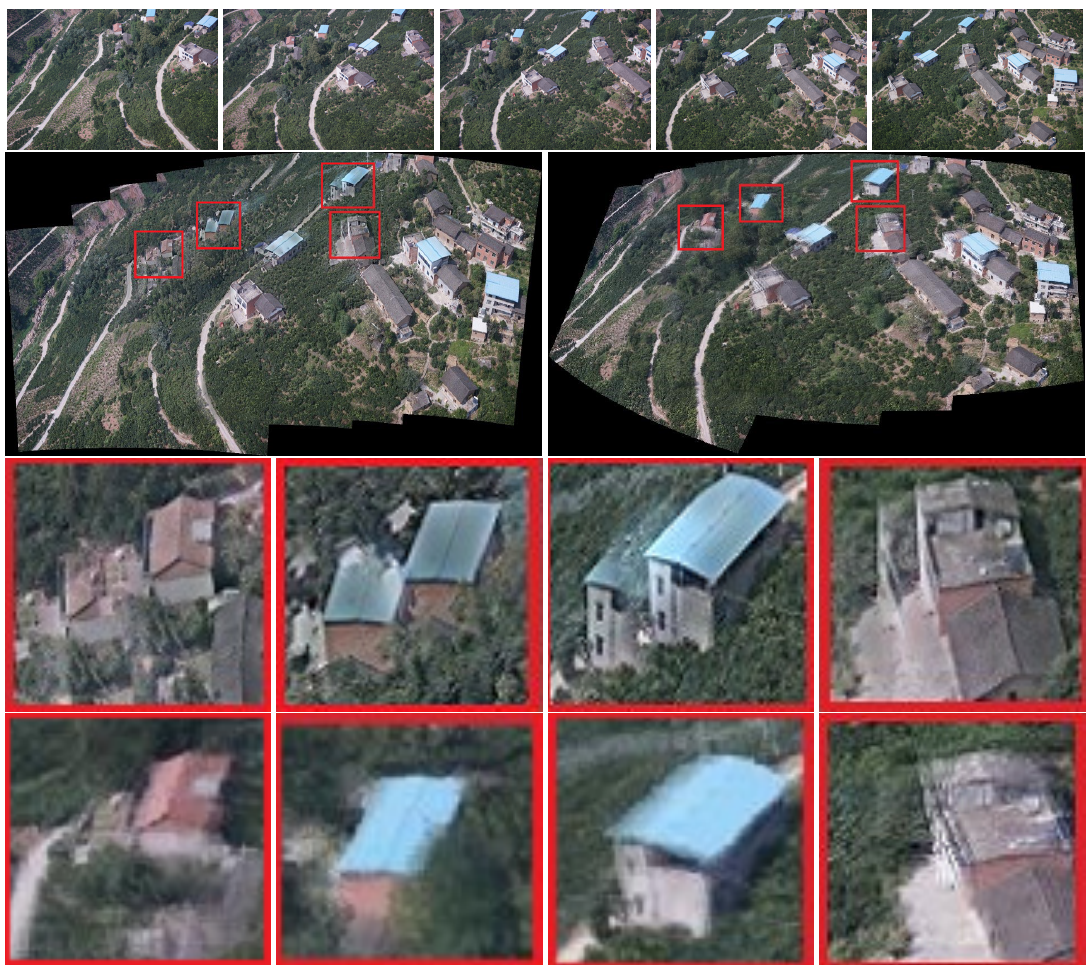
Figure 8. Experimental results of panoramic stitching. The first row is the image to be stitched together. The second row is the results of Autostitch and our method. Red boxes highlight the ghostly parts. The last two rows are the details of the red